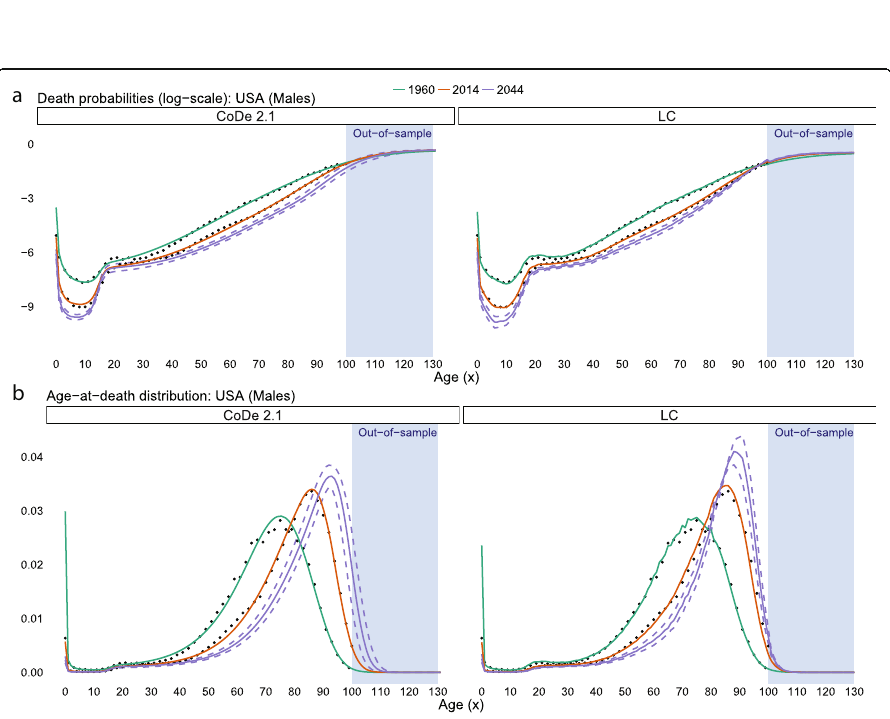
Fig. 9 Estimations and projections of the death probabilities and the age-at-death distribution for American males for the years 1960, 2014, and 2044 and for ages 0 – 130. CoDe 2.1 (left) and LC (right). The dotted lines are observations and the dashed lines are 95% projection intervals. The reference period is 1960 – 2014